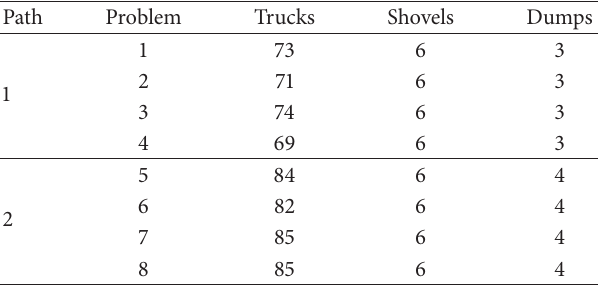
Table 1: Parameters of the problem